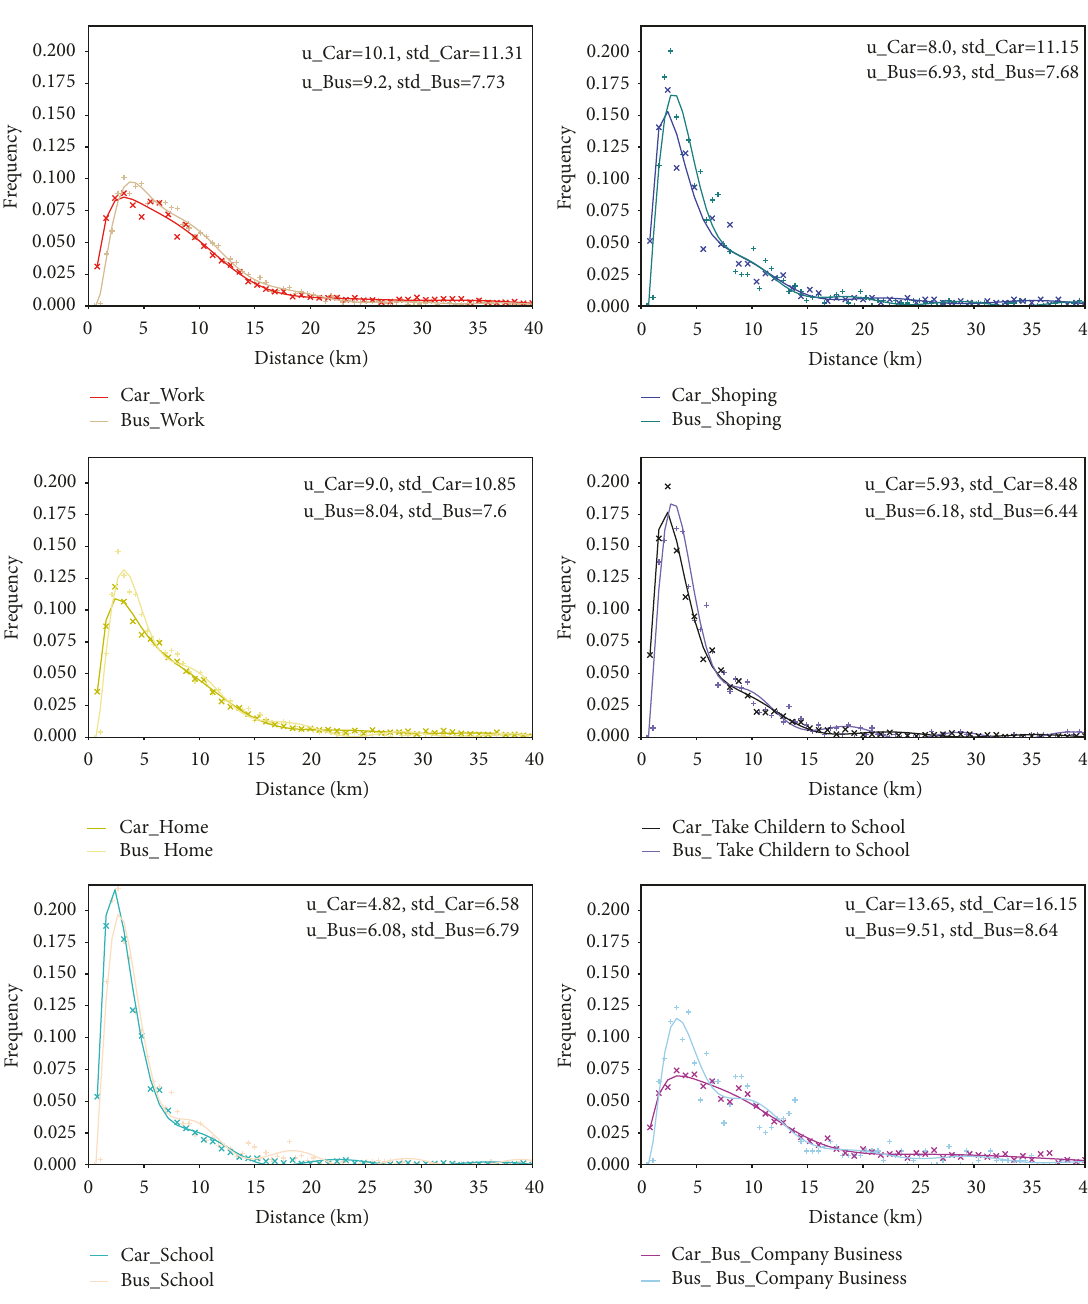
Figure 9: Car and bus travel distance distribution with different